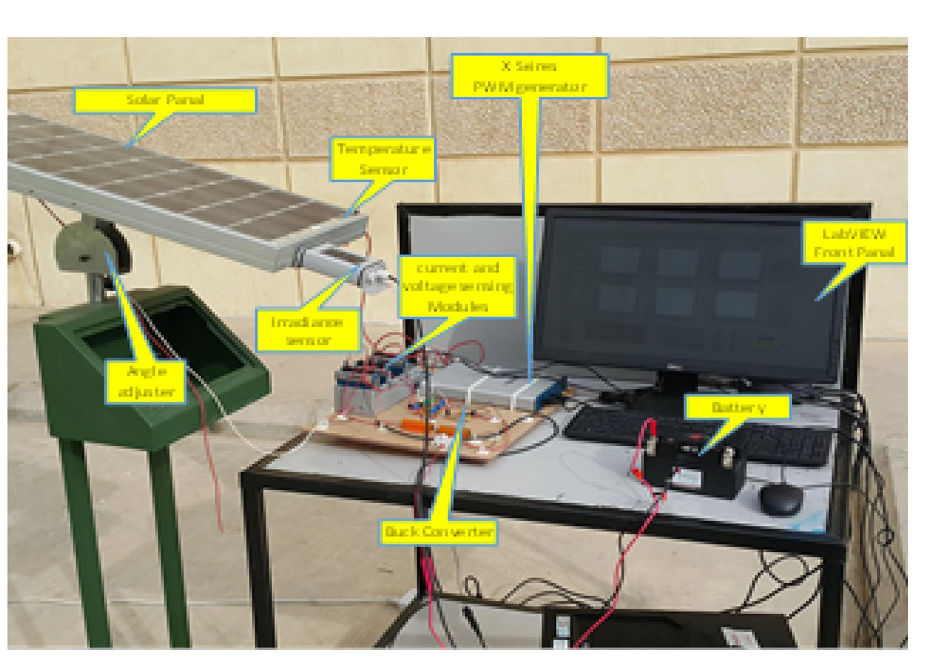
Figure 8. Experimental test